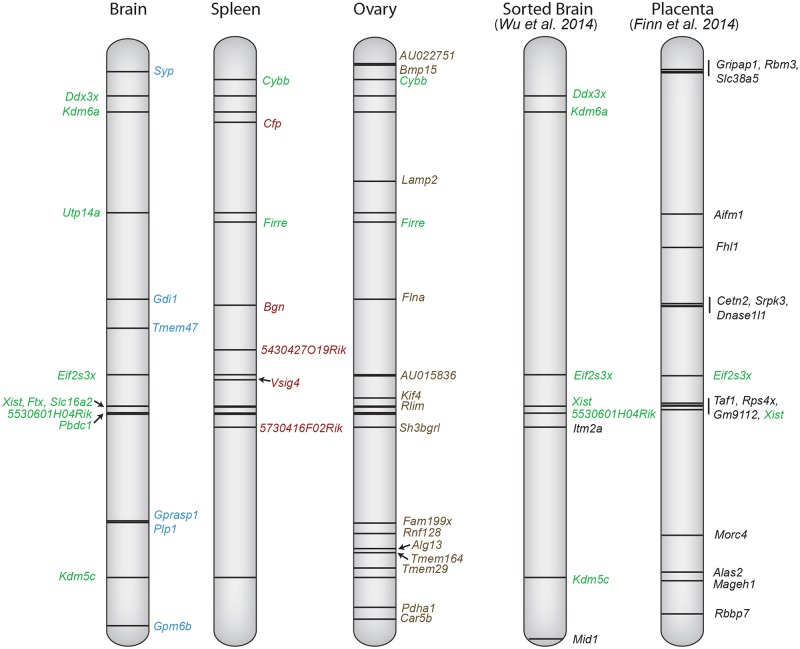
X chromosome escape maps differ between mouse tissues.The position of genes that escape XCI using a ≥2 Xi-SRPM cutoff (black lines) is shown at left for three tissues (brain, ovary and spleen) from F1 mice analyzed in our study. Gene names are color-coded to reflect their classification into group 1 (green, common in at least two tissues) or group 2 (blue, brain-specific escape; red, spleen-specific; brown, ovary-specific) based on our criteria (see Table 1). Coordinates at left are based on UCSC genome build NCBI37/mm9. For comparison, the genes reported to escape XCI in sorted brain cells from a M. musculus x M. castaneus cross [25], and genes reported to escape imprinted XCI in mid-gestation placenta from a M. musculus x M. castaneus cross [24] are shown at right. Genes labeled green are common between studies.